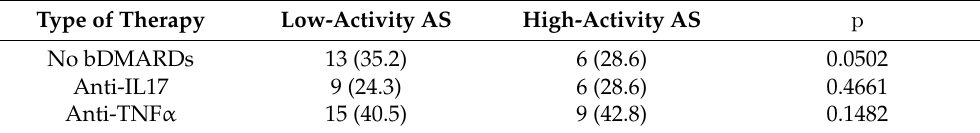
Table 10. Therapy-based patient distribution in activity-driven AS (n